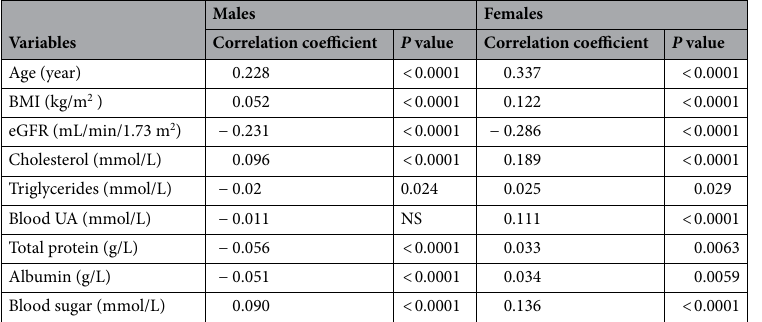
Table 2. Correlation between BUN values and clinical/biochemical variables in Chinese healthy adults. BMI body mass index; eGFR estimated glomerular filtration rate; UA uric acid; NS no significance.